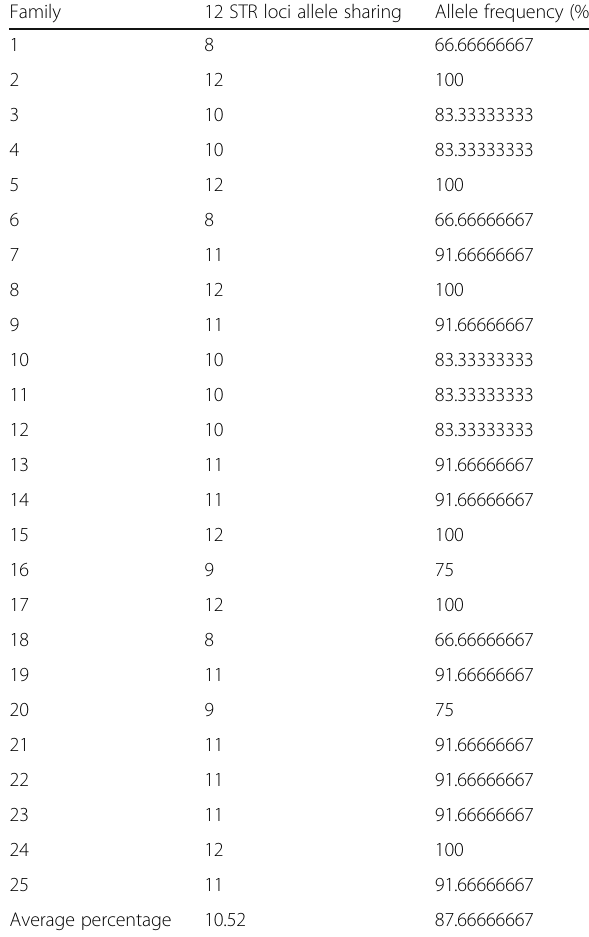
Table 3 Allele sharing and allele frequency full sibling in 12 loci